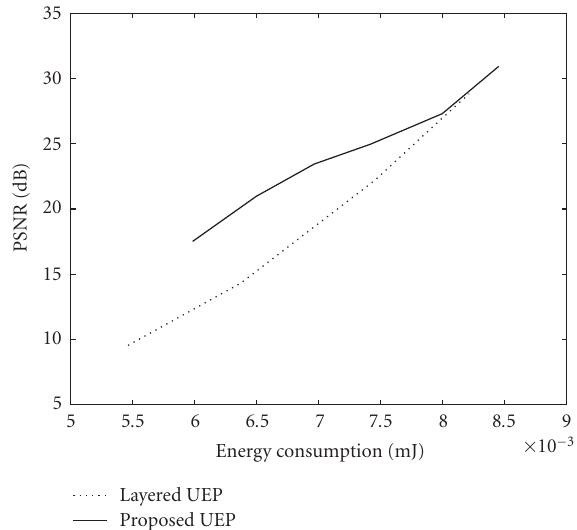
Figure 9: Image quality with di ff erent energy consumption.